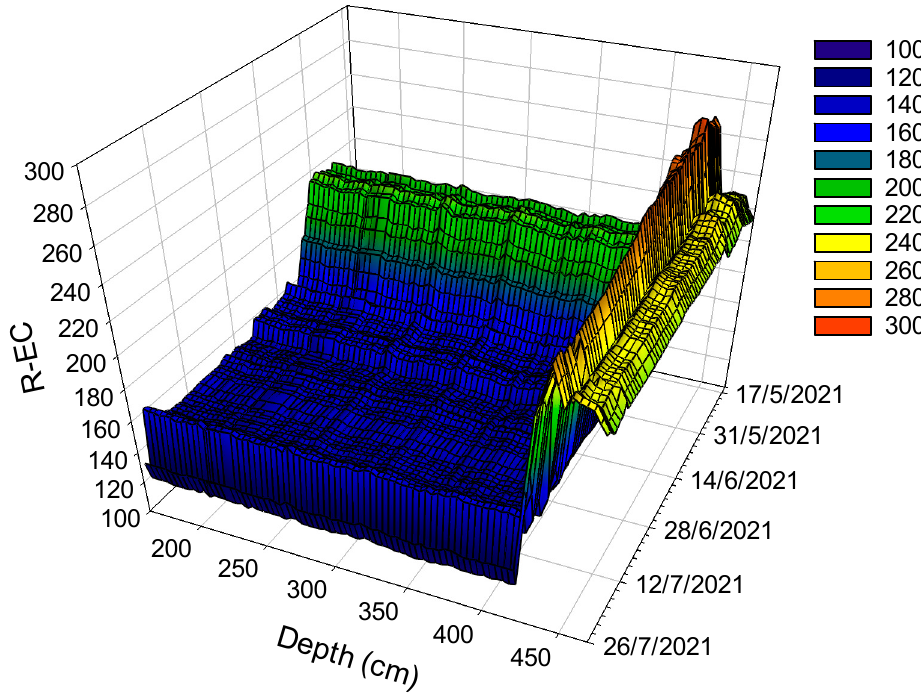
Figure 3. Results of real-time precision multi-layer sensor monitoring of the high-speed flocculation flat-bottomed sludge blanket clarifier from 15 May 2021 to 26 July 2021.